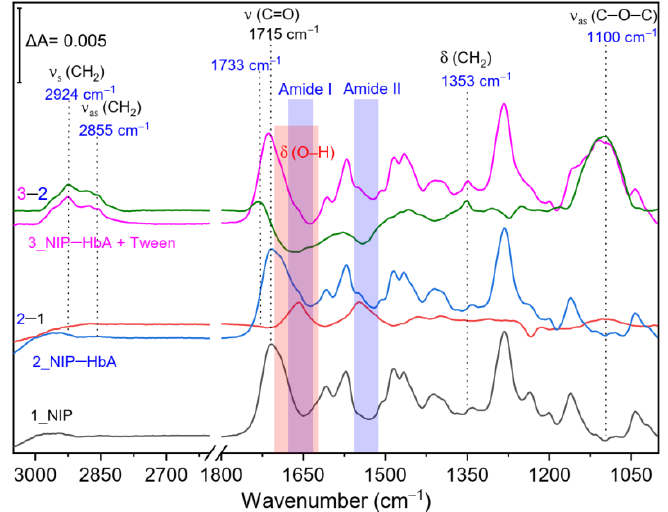
Figure 6. Effect of Tween on the HbA-NIP-nanofilm complex. The observed bands in trace 1 (dark) are attributed to the polyscopoletin NIP nanofilm. Trace 2 (blue) shows the unspecific HbA binding on the NIP, which is visualized in the corresponding difference spectrum between traces 2 and 1 (red spectrum). The related amides I and II absorptions are highlighted by the blue rectangle. Subsequent removal of HbA from the NIP film after addition of 0.05% Tween in PBS leads to spectral changes in amides I and II regions as depicted in trace 3 (magenta), these are displayed as negative absorptions bands in the respective difference spectrum between traces 3 and 2 (green trace). A concentration-dependent interaction of the surfactant with the polymer nanofilm is shown in the Supplementary Information (Figure S2).